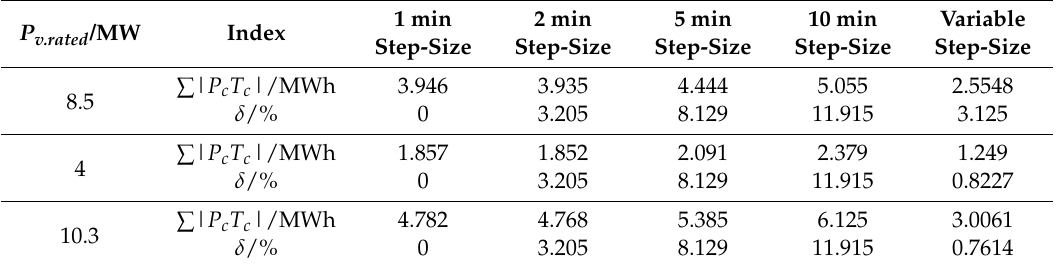
Table 5. Effects on ∑ | P c T c | and δ .